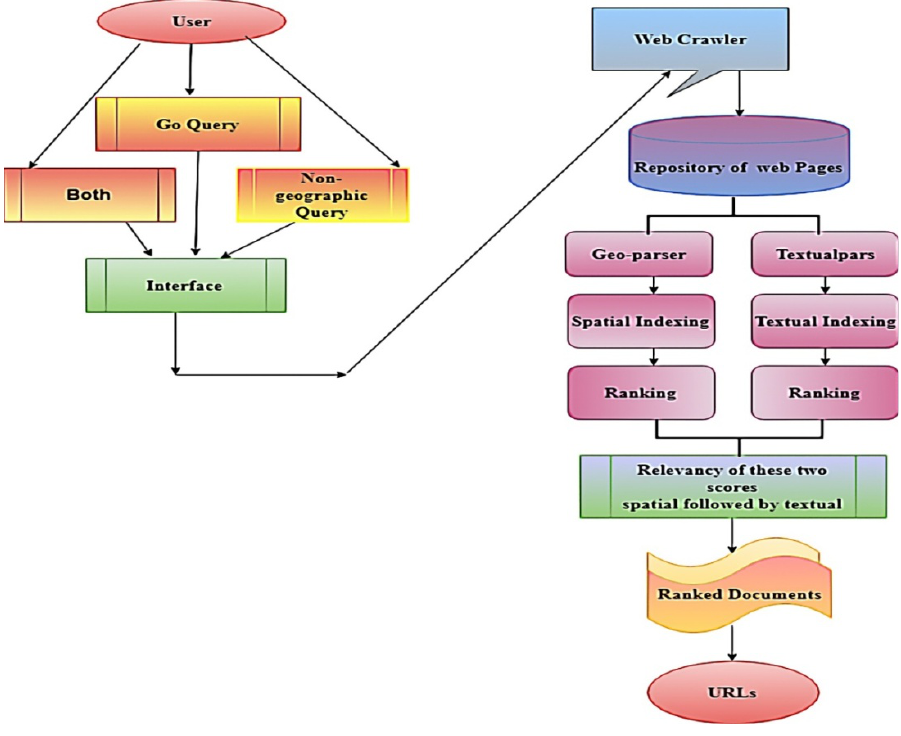
Figure 2. Architecture of Proposed Model